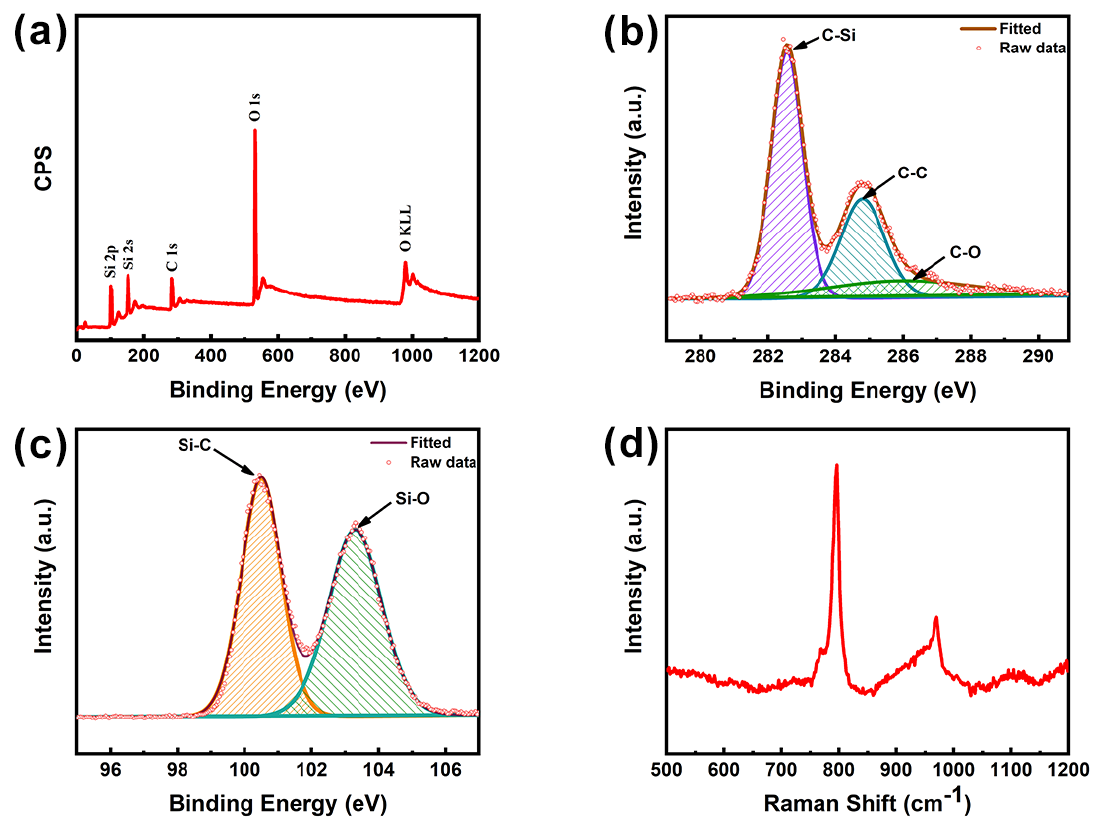
Figure 3. XPS spectra of SiC: ( a ) survey spectra, ( b ) C1S, and ( c ) Si2p; ( d ) Raman pattern of SiC.